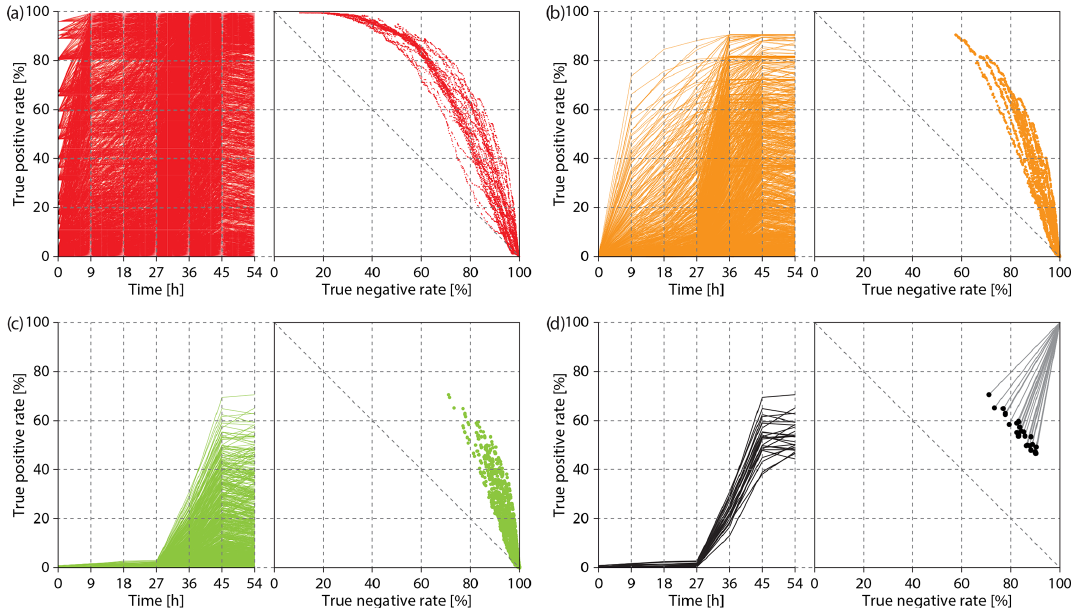
Figure 9. Temporal prediction rate for the seven time steps and rate of correctly predicted landslides (true positives) and non-landslides (true negatives) at a FOS falling below 1.0 for the calibration runs. All 10000 calibration runs (a) , calibration runs which satisfy assumption 1 ( b ; n = 7300), calibration runs which satisfy assumption 2 ( c ; n = 1134) and the 25 calibration runs which predict most landslides and non-landslides (d) . In (d) , only the coordinates with the highest true positive rate for the 25 calibration runs are shown. The grey lines in (d) indicate the D2PCs of these runs. Table 6. Prediction rates of the model ensemble for the landslide-triggering rainfall event in August 2005. TPR: true positive rate, TNR: true negative rate, FPR: false positive rate, FNR: false negative rate, D2PC: distance to perfect classification, AUC: area under the ROC curve. All calibration runs Stable at t = 0 Most landslides at t = 45 Best 25 runs Prediction Minimum Maximum Minimum Maximum Minimum Maximum Minimum Maximum TPR 0.0% 99.4% 0.0% 90.4% 0.0% 0.6% 100.0% 100.0% FPR 0.0% 89.4%